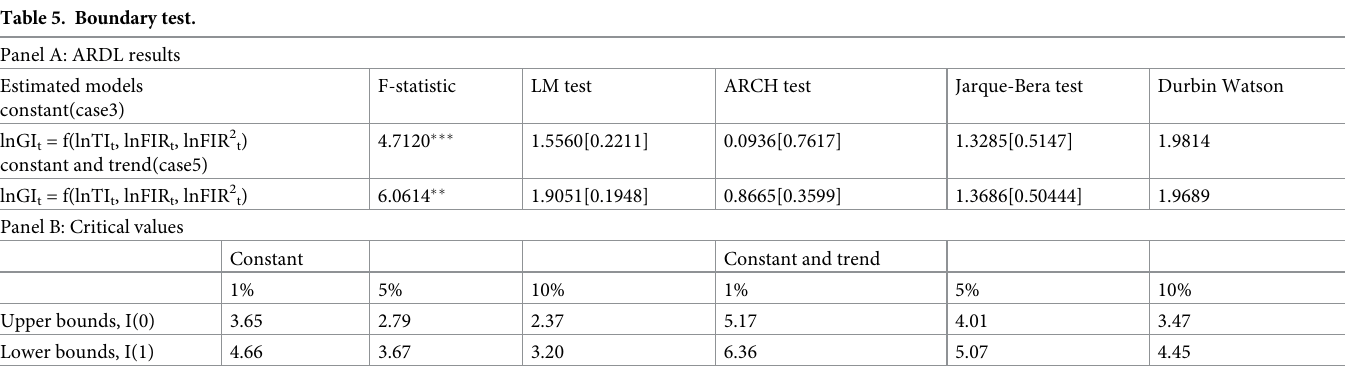
Table 5. Boundary